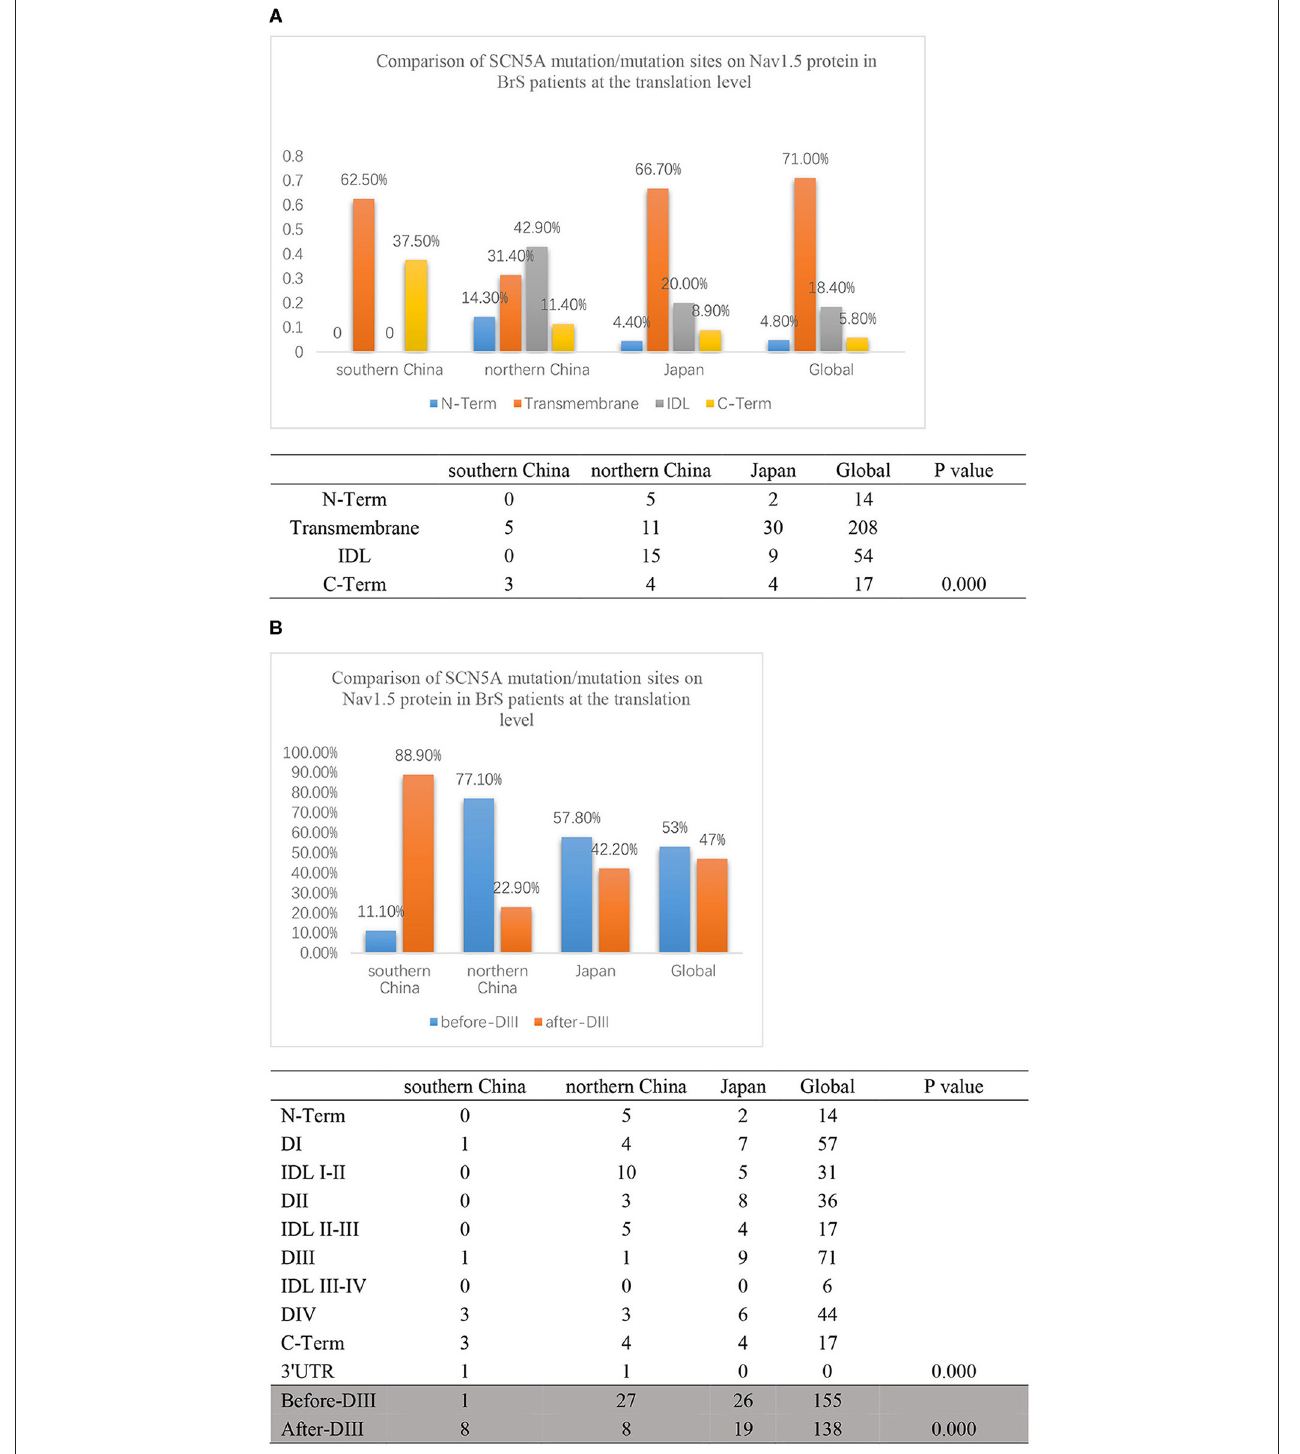
FIGURE 5 | (A) The translation comparison of the SCN5A mutation/variation distribution on the Nav1.5 protein structure between southern China and northern China. Nav1.5 protein was distinguished by N-term, Transmembrane regions, IDL, C-term, and other parts. The light blue columns represent the N-terminus region. The orange columns represent the transmembrane region. The gray columns represent the IDL region. The yellow columns represent the C-terminus region. (B) The translation comparison of the SCN5A mutation/variation distribution on the Nav1.5 protein structure between southern China and northern China. Nav1.5 protein was distinguished by before-DIII and after-DIII. The blue columns represent before-DIII parts. The orange columns represent after-DIII parts.